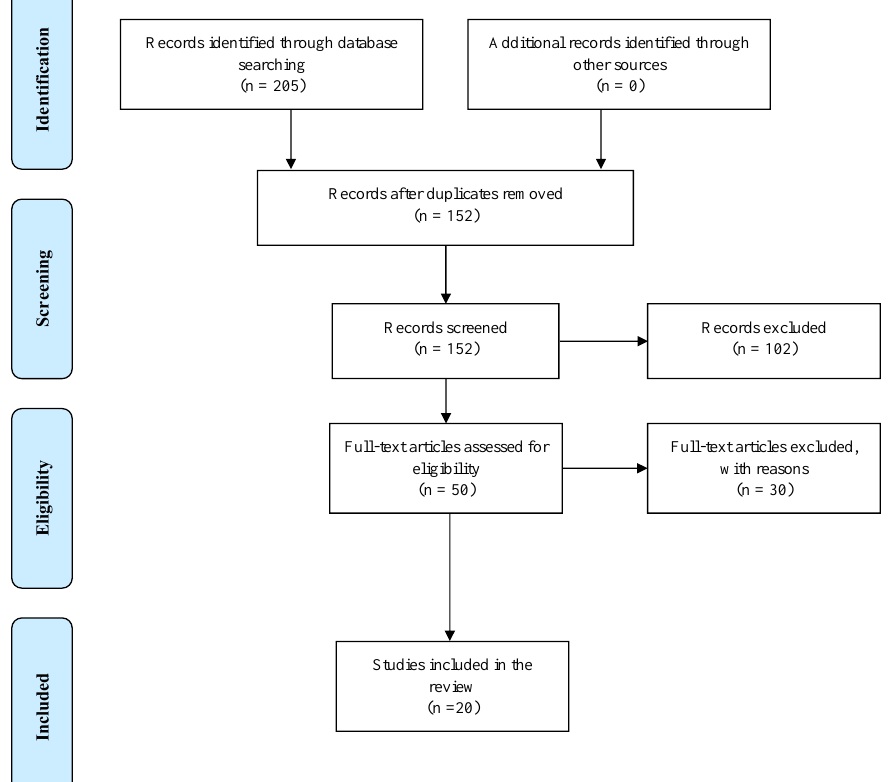
Figure 1. PRISMA Flow Diagram of Included Studies, adapted from Ref. [9].